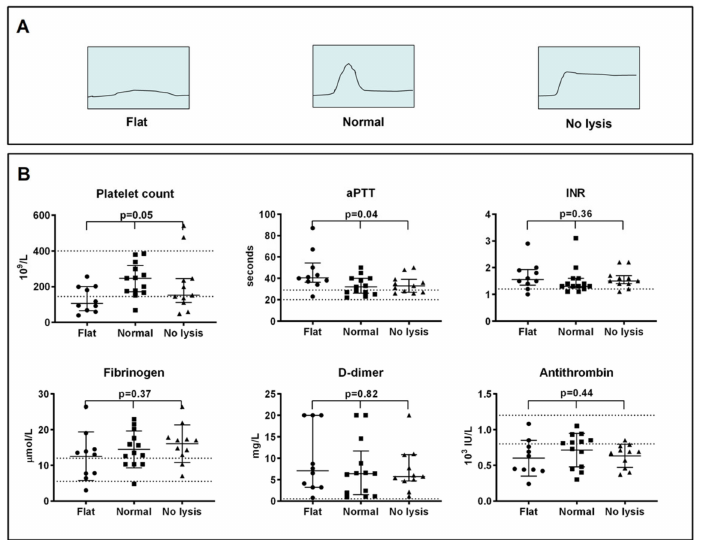
Figure 1. ( A ) Illustration of “flat”, “normal” and “lysis-resistant” fibrin clot formation and lysis curves; ( B ) Standard coagulation parameters in patients with flat ( n = 10), normal ( n = 13) and lysis- resistant ( n = 11) curves. Median with interquartile range is shown. p -values indicate comparison between all three groups (one-way analysis of variance or Kruskal–Wallis test). Dotted lines indicate upper/lower reference limits as established by our laboratory. Abbreviations: aPTT, activated partial thromboplastin time; INR, international normalised